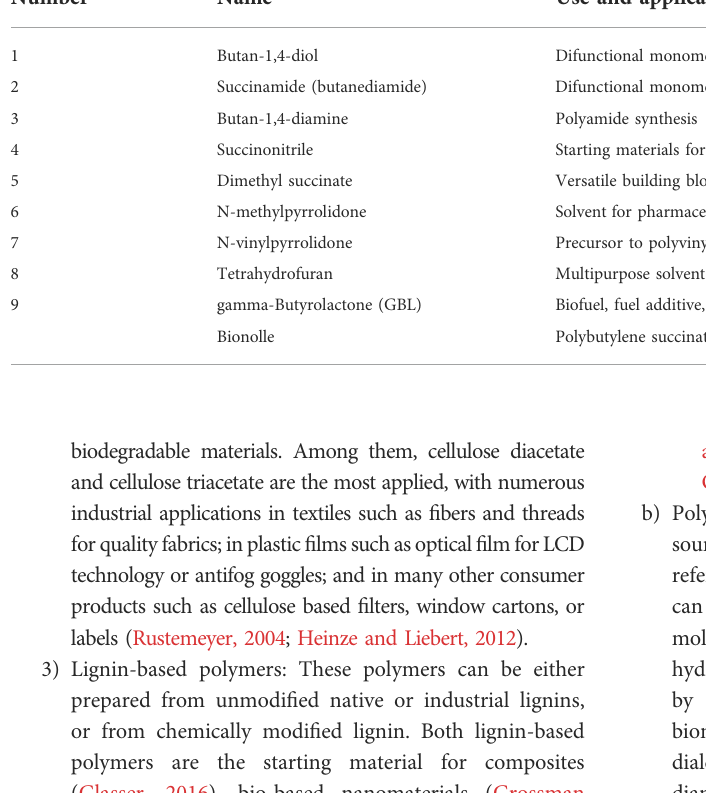
TABLE 7 Uses and applications of bio-derivatives from succinic